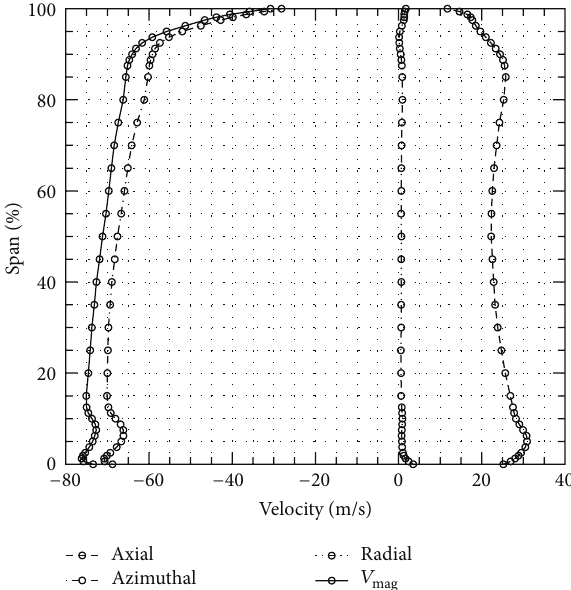
Figure 23: Mass averaged FHP measured velocity components,